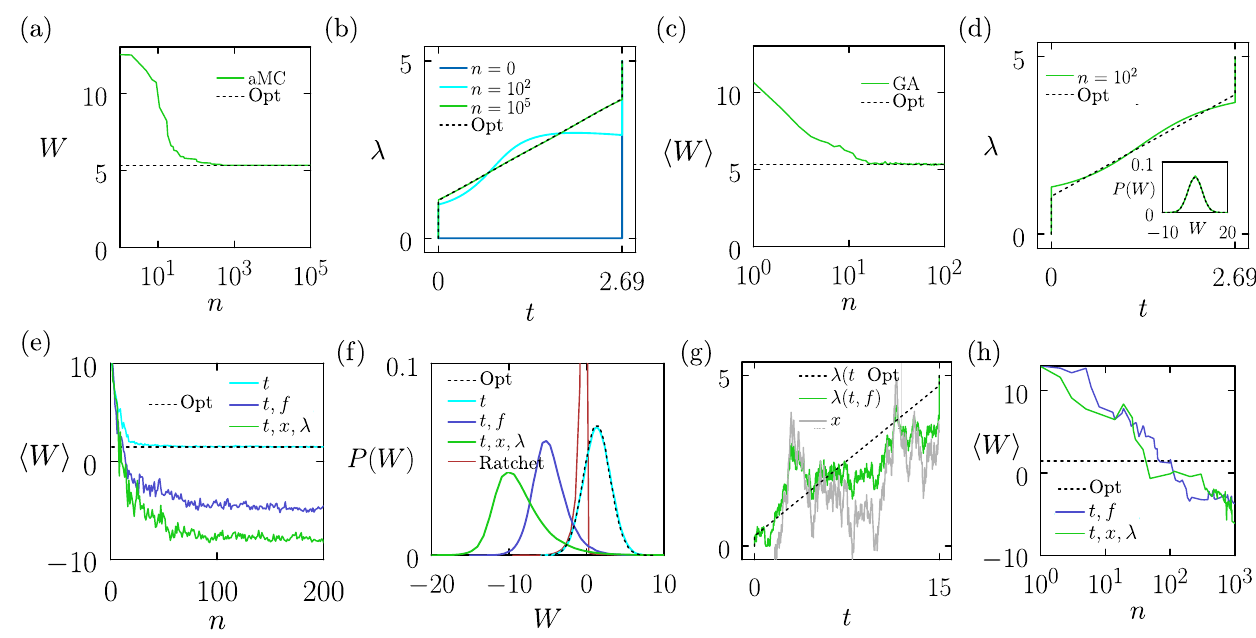
FIG. 2. Particle pulled by a trap. (a) Work W as a function of the aMC steps n for a single trajectory of the noise-free version of Eq. (2) Þ (green line). The black dashed line is (mimicking a large number of trajectories) under the neural-network demon protocol λ ¼ g θ ð t=t f Þ learned after n ¼ 0 ; 10 2 , and 10 5 aMC steps (colors), the analytic result of Ref. [16]. (b) Time-dependent protocol λ ¼ g θ ð t=t f compared to the optimal protocol (black dashed line). (c,d) Same as panels (a,b), but now the order parameter h W i is calculated as an average over 10 4 noisy trajectories. GA is used as a method of training; n is the number of generations (here and elsewhere, the GA result indicates the performance of the best demon in each generation). The learned protocol is a near-optimal one that, in practical terms, cannot be distinguished from the optimal protocol: The inset to panel (d) shows the work distributions produced by each. (e) Mean work h W i (averaged over 10 4 trajectories) versus GA generation n for demon protocols expressed as a function of t (cyan line), t and f (blue line), and t , x , and λ (green line). The black dashed line is the analytic result of Ref. [16]. (f) Work distributions for demon protocols learned after 200 generations (colors), together with that of a ratchet (red line). (g) Single Monte Carlo trajectory under the demon ( t , f )- protocol learned after 200 generations. (h) Similar to panel (e), but averaging h W i over only 10 2 trajectories and using aMC as a training ¼ 2 . 69 (a) – (d) and 15 (e) – method. Trajectory lengths: t f